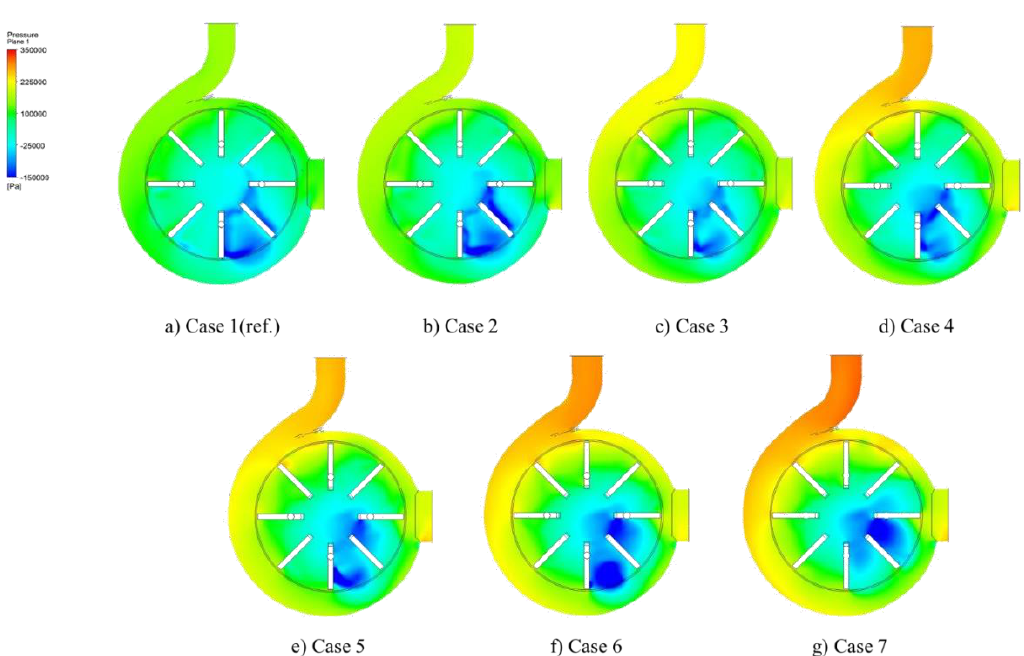
Figure 11. Example of numerical results on pressure distribution extracted from Je and Kim [11] for a given flow rate and di ff erent interblade clearance gaps. Interblade gap increases from Case 1 (large gap) to Case 7 (no gap, full blade